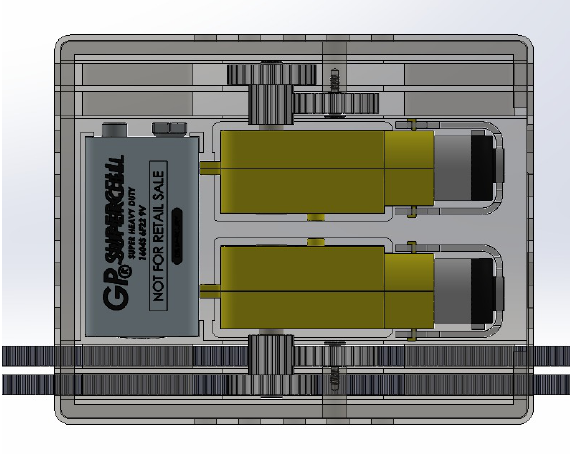
Figure 6. 3D design of gearbox with DC motors and